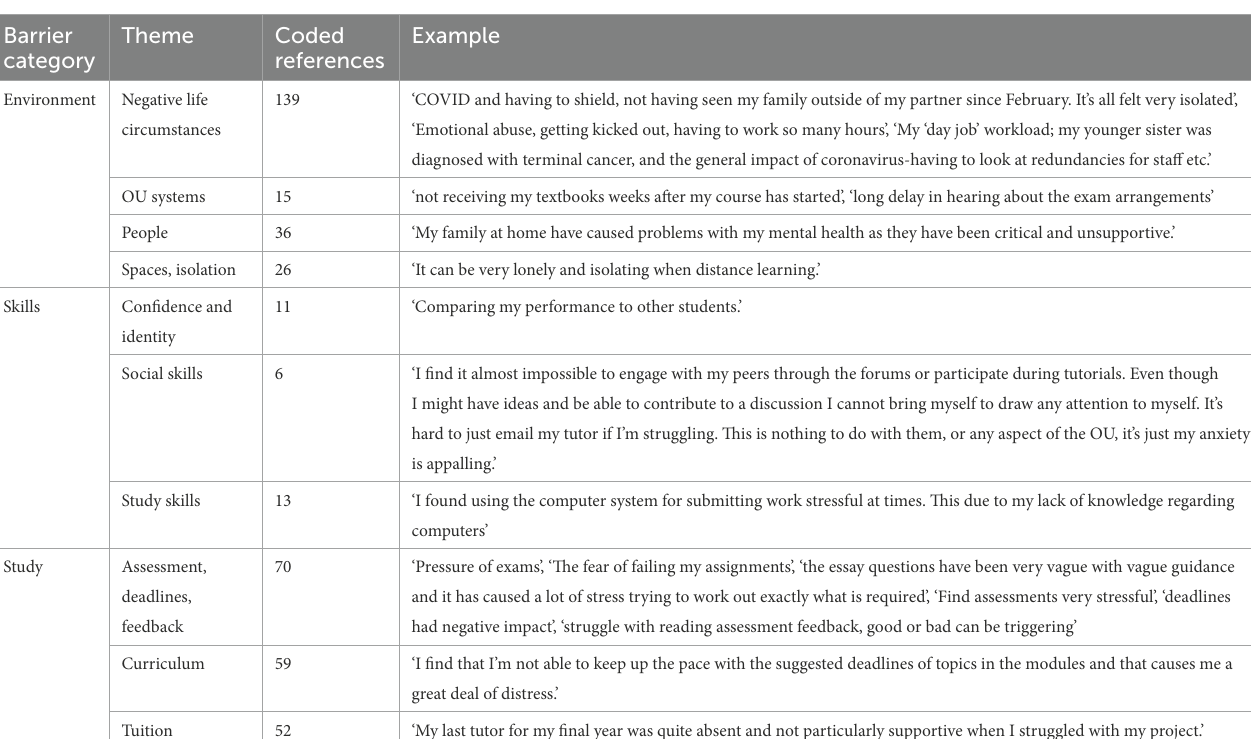
TABLE 2 Survey findings: barriers by mental health declaration. Category Assessment on